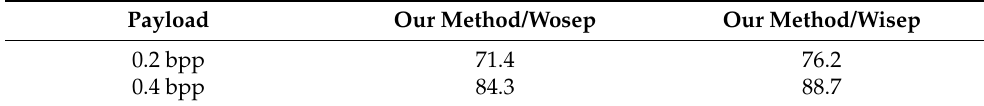
Table 1. Detection accuracy (%) for steganography at 0.2 bpp and 0.4 bpp on BOSSBase1.01 using S-UNIWARD for networks without and with the introduction of the separable convolution module.